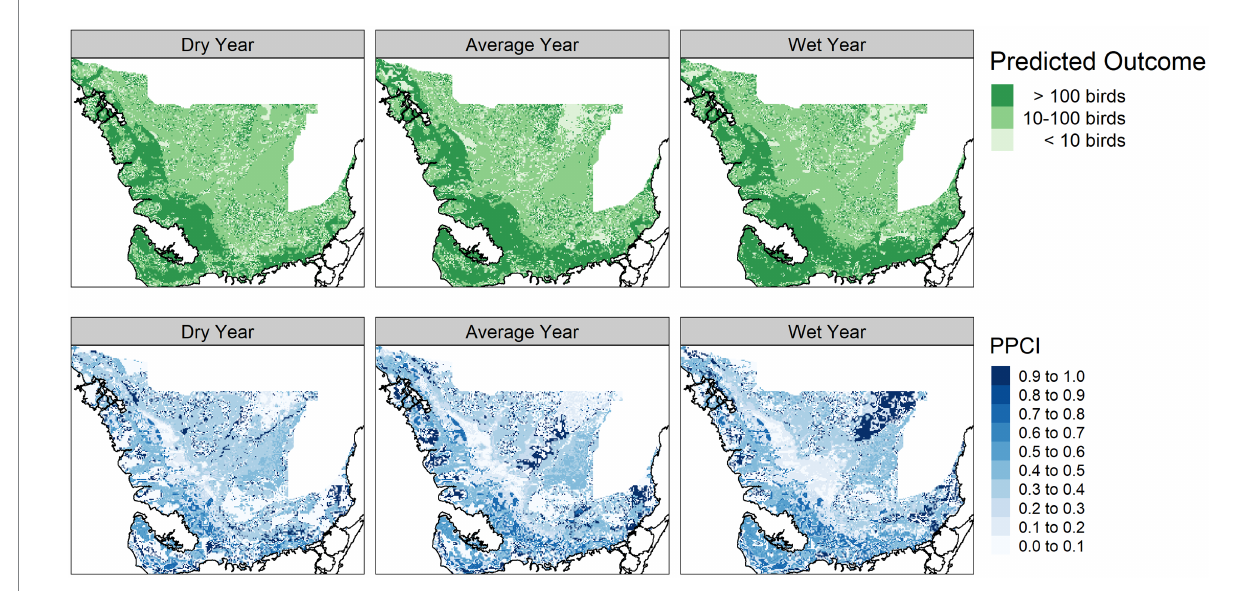
FIGURE 6 Predicted wading bird colony size module outcome (top panel) and posterior probability certainty index (PPCI, bottom panel) for a dry (2014), average (2007), and wet (2003) year chosen from 2000–2017.